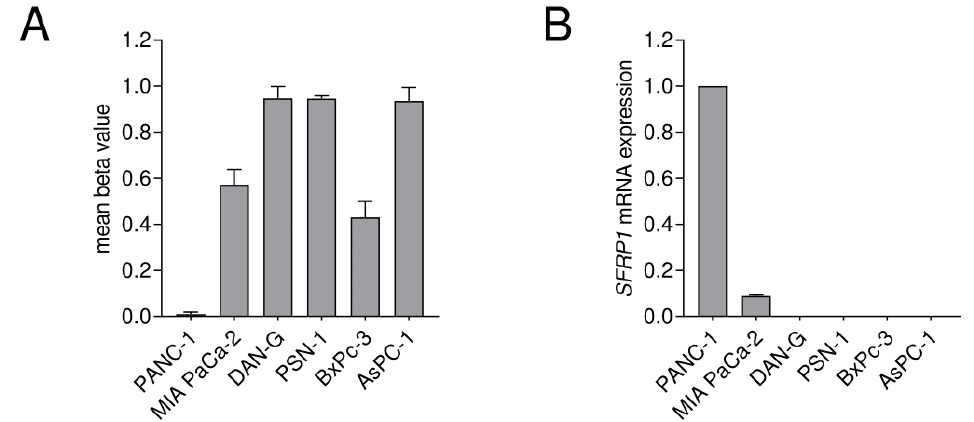
acinar tissue and pancreatic ductal adenocarcinoma with connective tissue fraction. The boxes indicate the macrodissected cells used for DNA isolation (blue = low SFRP1 methylation, red = high SFRP1 methylation). ( C ) Mean DNA methylation status of the CpG sites 1–7 for isolated connective tissue vs. normal tissue (grey) is comparable.